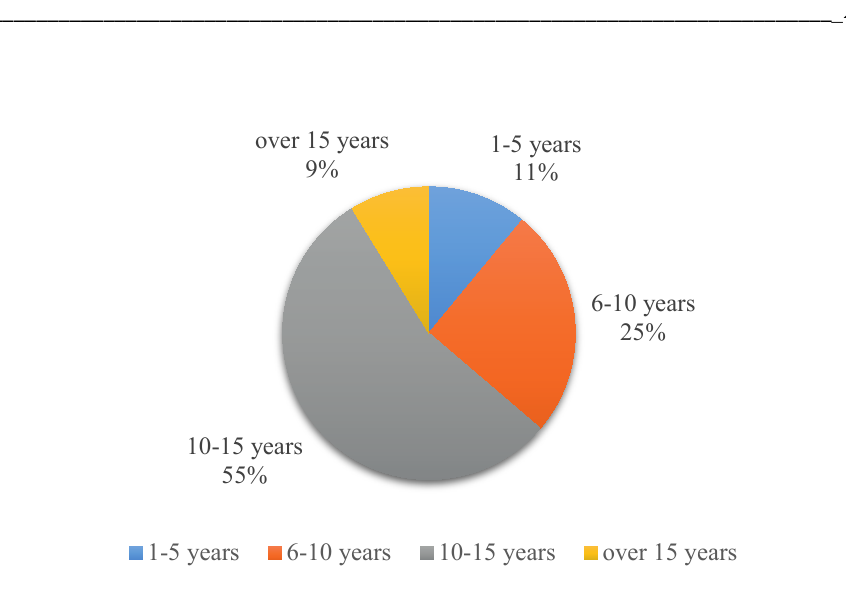
Fig. 2. The professional experience in safety management.